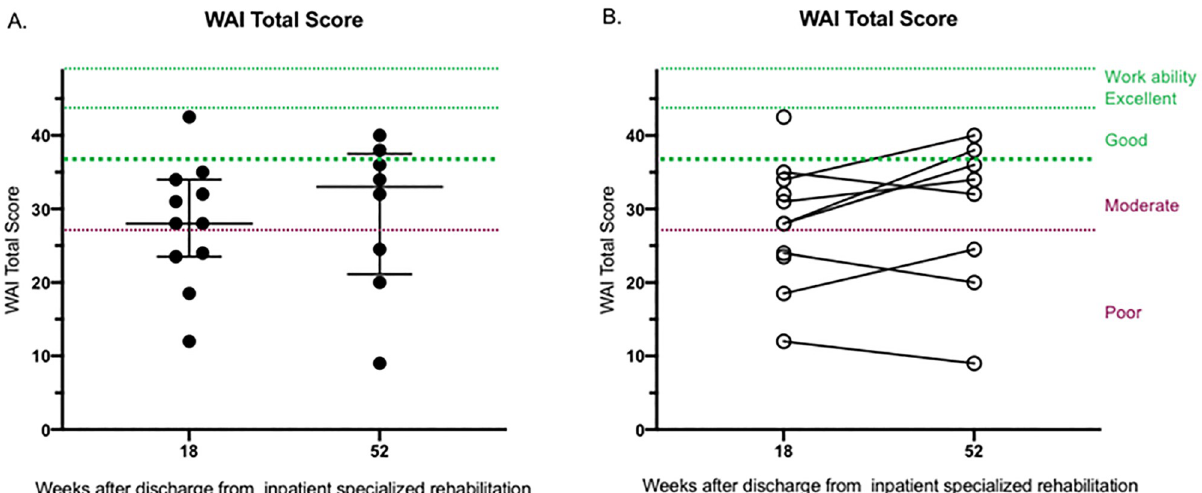
Fig 1. WAI total score per person at 18 and 52 weeks (A) and WAI total score change per person from 18 to 52 weeks (B) after inpatient rehabilitation discharge. The level of work ability according to WAI score is indicated by dotted lines. There was no statistically significant difference in the WAI score between 18 and 52 weeks post discharge, p =